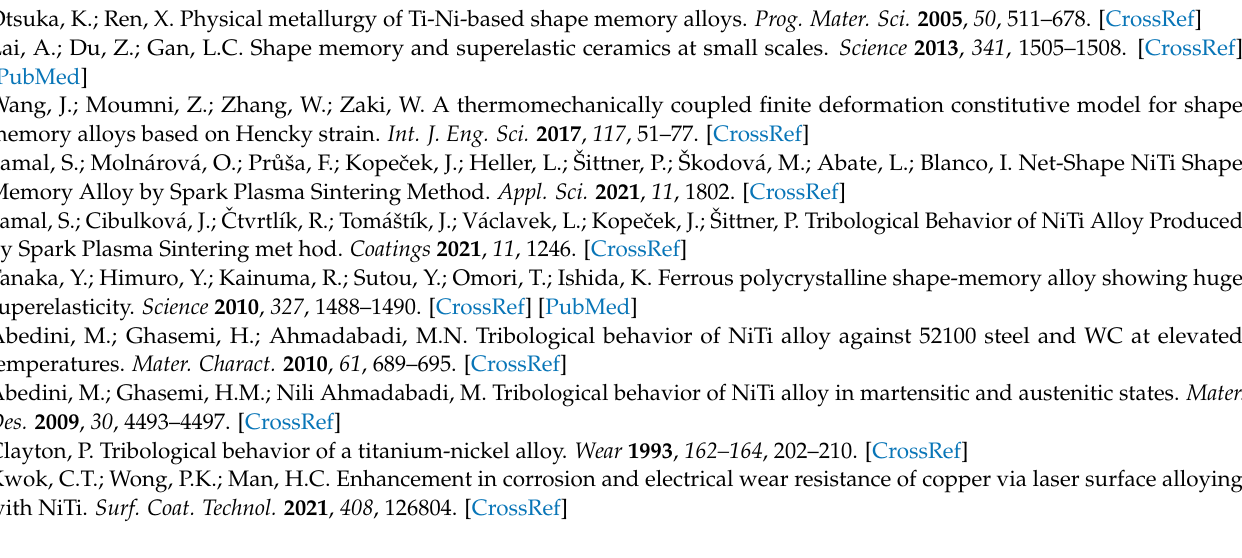
Figure S5: Elemental mapping for Ni and Ti in sample 1 and 2, that corresponds to Figure S1 (a and c); Figure S6: XRD spectrum for sample 1 and 2 with martensite, austenite and intermetallic